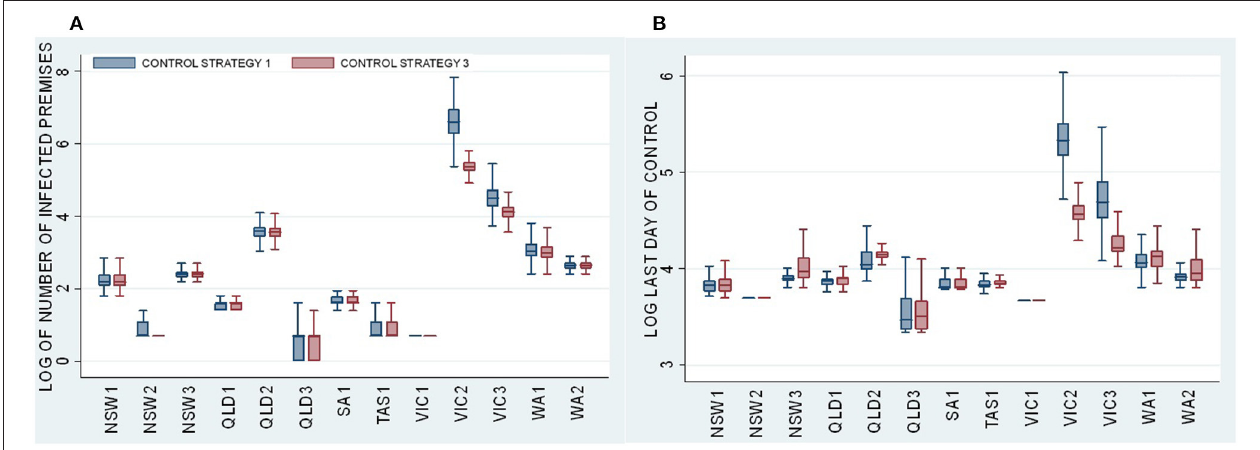
FIGURE 2 | Boxplots of (A) the log of total number of IPs and (B) the log of last day of control for the Control Strategy 1 stamping out strategy (blue) and the Control Strategy 3 vaccination strategy (red) for each incursion scenario.